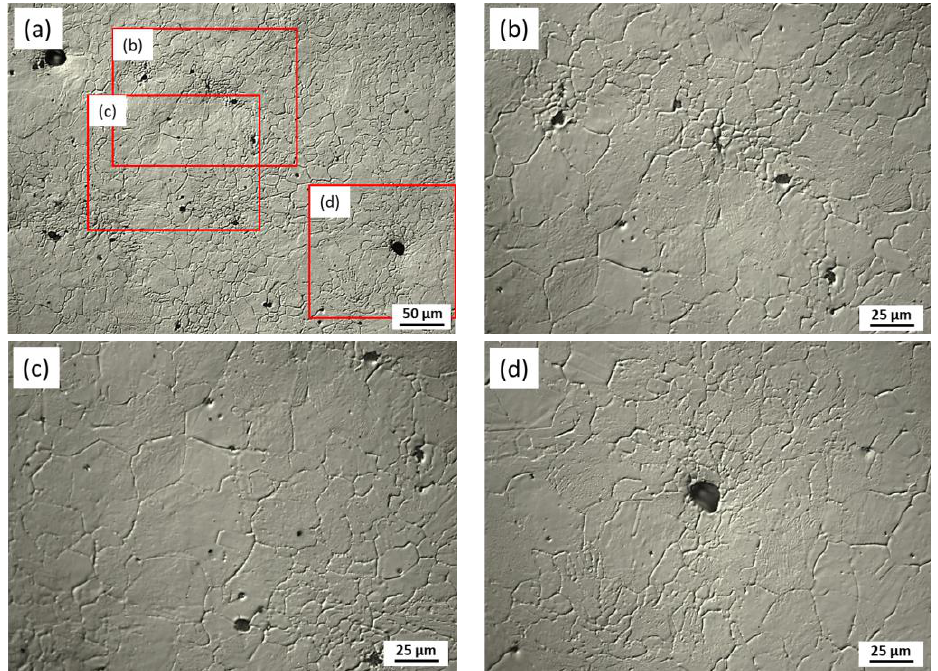
Figure 4. Light optical microscopy (LOM) micrographs of the prior austenite grain boundaries revealed by thermal etching. ( a ) Bright field image of the microstructure at a low magnification; ( b – d ) Micrograph corresponding to the red-square in image ( a ), using Nomarski microscopy (DIC).